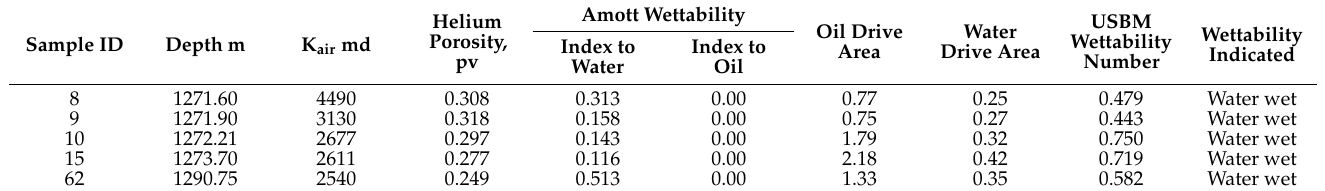
Table 2. Amott-USBM wettability measurements of core samples used in correlating core to log wettability.